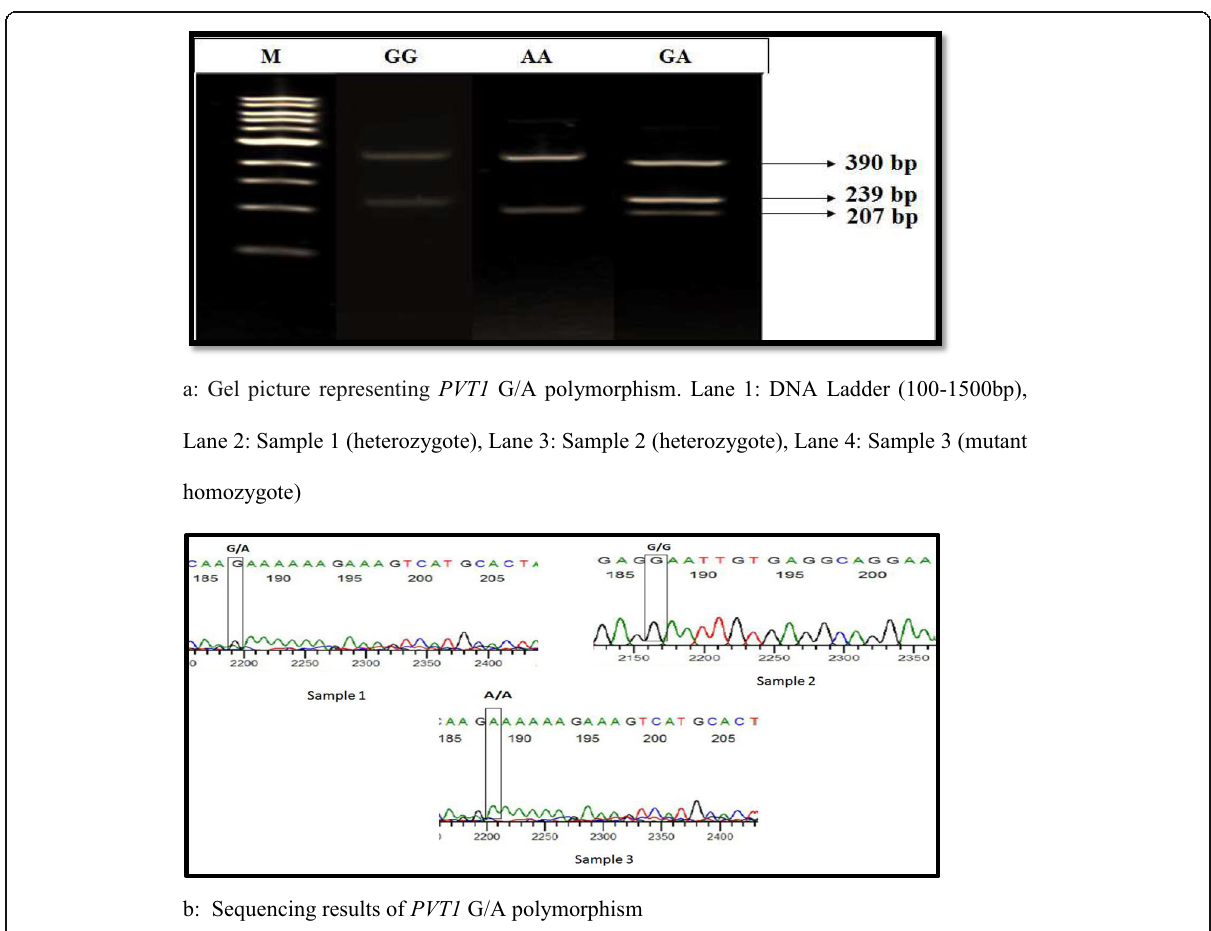
Fig. 2 a Gel picture representing PVT1 G/A polymorphism. Lane 1, DNA ladder (100 – 1500 bp); lane 2, sample 1 (heterozygote); lane 3, sample 2 (heterozygote); and lane 4, sample 3 (mutant homozygote). b Sequencing results of PVT1 G/A